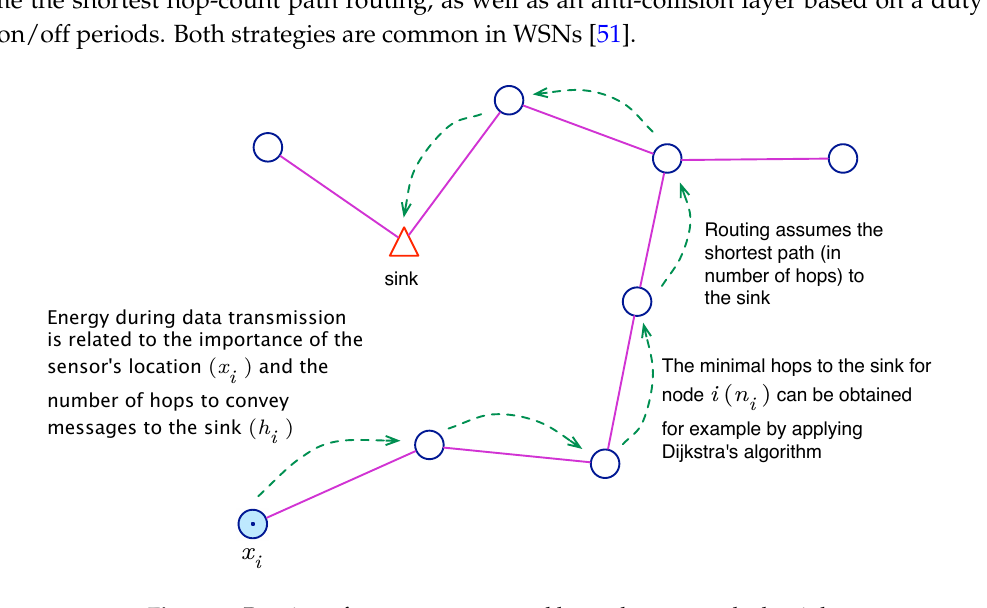
Figure 3. Routing of messages generated by node x i towards the